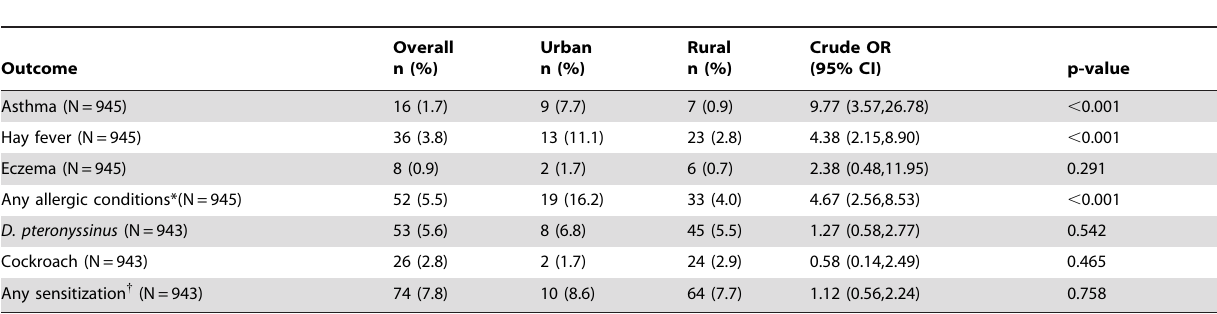
(Table 2). Self-reported asthma, hay fever and eczema were all more prevalent in urban than rural women, significantly so for asthma and hay fever (Table 2). There was no significant difference in allergic sensitization by area of residence (Table 2). Table 2. Prevalence of allergic conditions and sensitization among women by area of